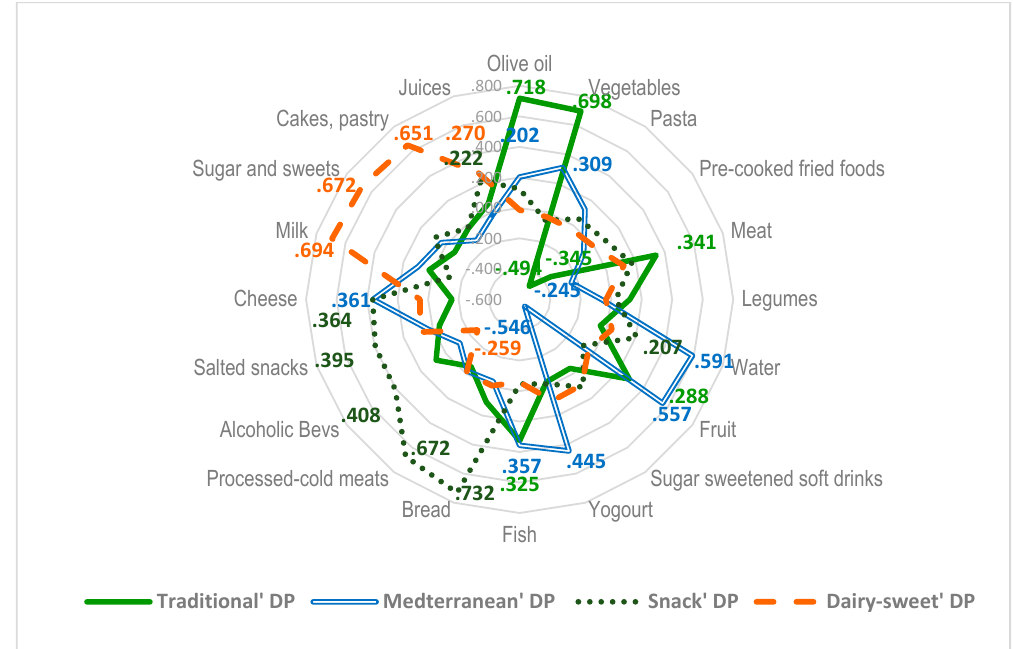
Figure 1. Factor loadings after varimax rotation on identified dietary patterns of food groups retained. Eigenvalues: Traditional DP = 2.15; Mediterranean DP = 1.64; Snack DP = 1.55; Dairy-sweet DP = 1.28. Percent of variance explained: Traditional DP : 8.74%; Mediterranean DP: 8.39%; Snack DP : 8.19%; Dairy sweet DP: 7.74%. Total variance explained 33.07%. Absolute values less than 0.20 are not shown.